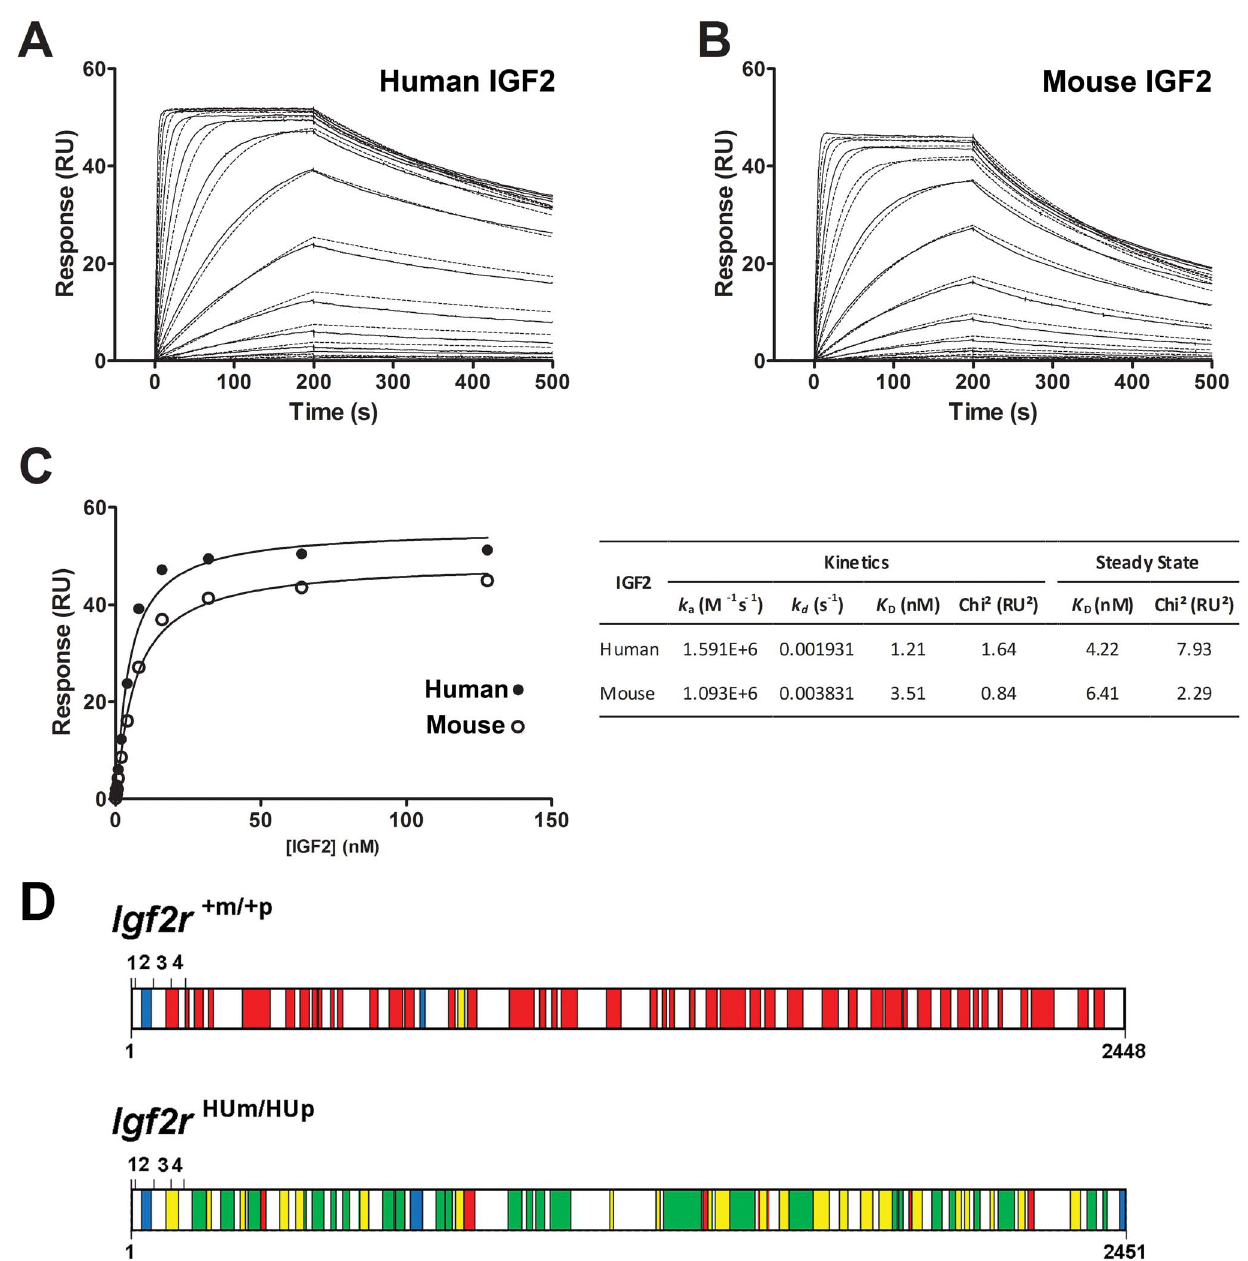
Figure 7. Surface Plasmon resonance binding kinetics of IGF2 binding to human IGF2R, and mass spectrometry (LCMS) of immune- precipitated liver IGF2R from control Igf2r + m/ + p and homozygote transmission of Igf2r + HUm/HUp . Immobilised human IGF2R on a biosensor chip were bound to either recombinant human (A) or mouse (B) IGF2 at increasing concentrations, and real time kinetics fitted to a 1:1 binding model. (C) steady state binding kinetics were also calculated for both interactions and tabulated. Mouse IGF2 has slightly lower K D (nM). (D) peptides identified by mass spectrometry in samples of immuno-precipitated Igf2r + m/ + p (WT) and Igf2r HUm/HUp . In both samples, red boxes depict unique peptides matching mouse IGF2R protein sequence, green boxes depict unique peptides matching human IGF2R protein sequence, and yellow boxes depict areas of overlap between mouse and human peptides. Blue boxes depict peptides common to both sequences. Exons 1–4 are represented by upper numbers, lower numbers represent amino acid residue number. Both mouse and human peptides were detectable in suggesting trans-splicing and generation of mouse and humanised proteins from the humanised alleles. doi:10.1371/journal.pone.0057270.g007 with Prolong anti-fade (Invitrogen). Fluorescent images were Olympus microscope BX60 in combination with Nuance CCD acquired using a confocal microscope Olympus Fluoview FV1000 system and software. with each image having a size of 2048 6 2048 pixels. Images of Haematoxylin & Eosin (H&E) sections were acquired by an